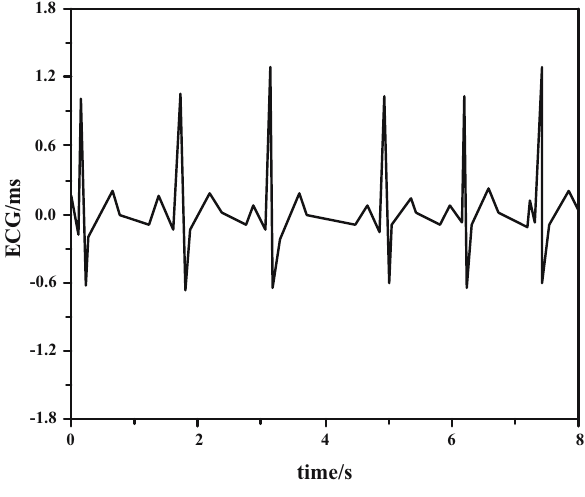
Figure 4: ECG data